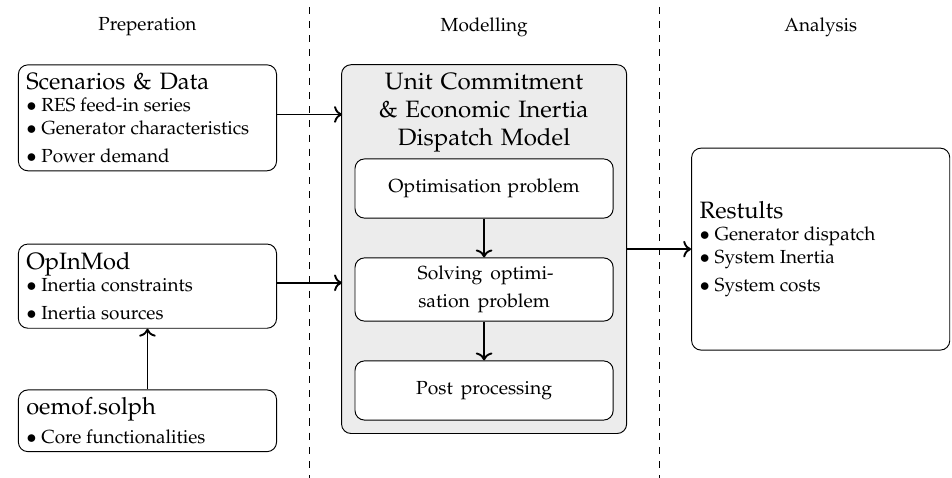
Figure 2. Schematic representation of the three-step modelling process. Scenarios are defined and data such as feed-in series of variable RES, generator characteristics and power demand series are used to feed the unit dispatch and economic inertia dispatch model. To complete the initialisation part of the modelling process, OpInMod including oemof’s core functionality is used to build an energy system. In the second modelling step, the optmisation problem is created and solved by an external solver. The post-processing function processes solver outcome and prepares it for the third step: the analysis. Exported results such as electrical power flow, system inertia data and system cost results are further